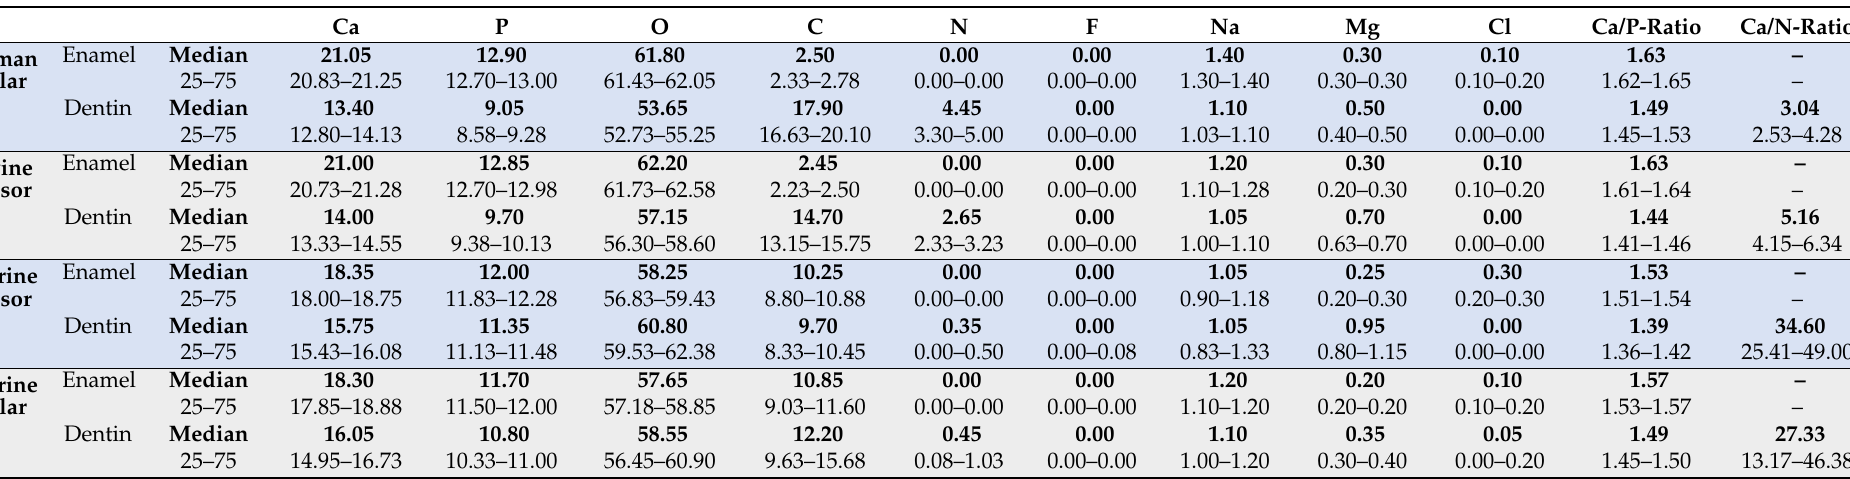
Table 1. Relative elemental composition (summarized areas) and Ca/P- and Ca/N-Ratios of all tooth types for enamel and dentin [At%], median and 25–75% percentiles of six specimens per group (data also shown in Figures 5 and 6; p -values in Tables 2 and 4). Elements Fe and S were measured but are not shown because the median and 25–75% percentiles were 0.00 At% in field scans.